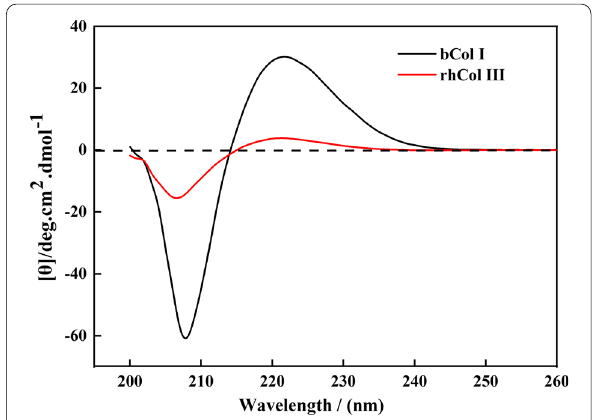
Fig. 2 Circular dichroism spectra of rhCol III and bCol I